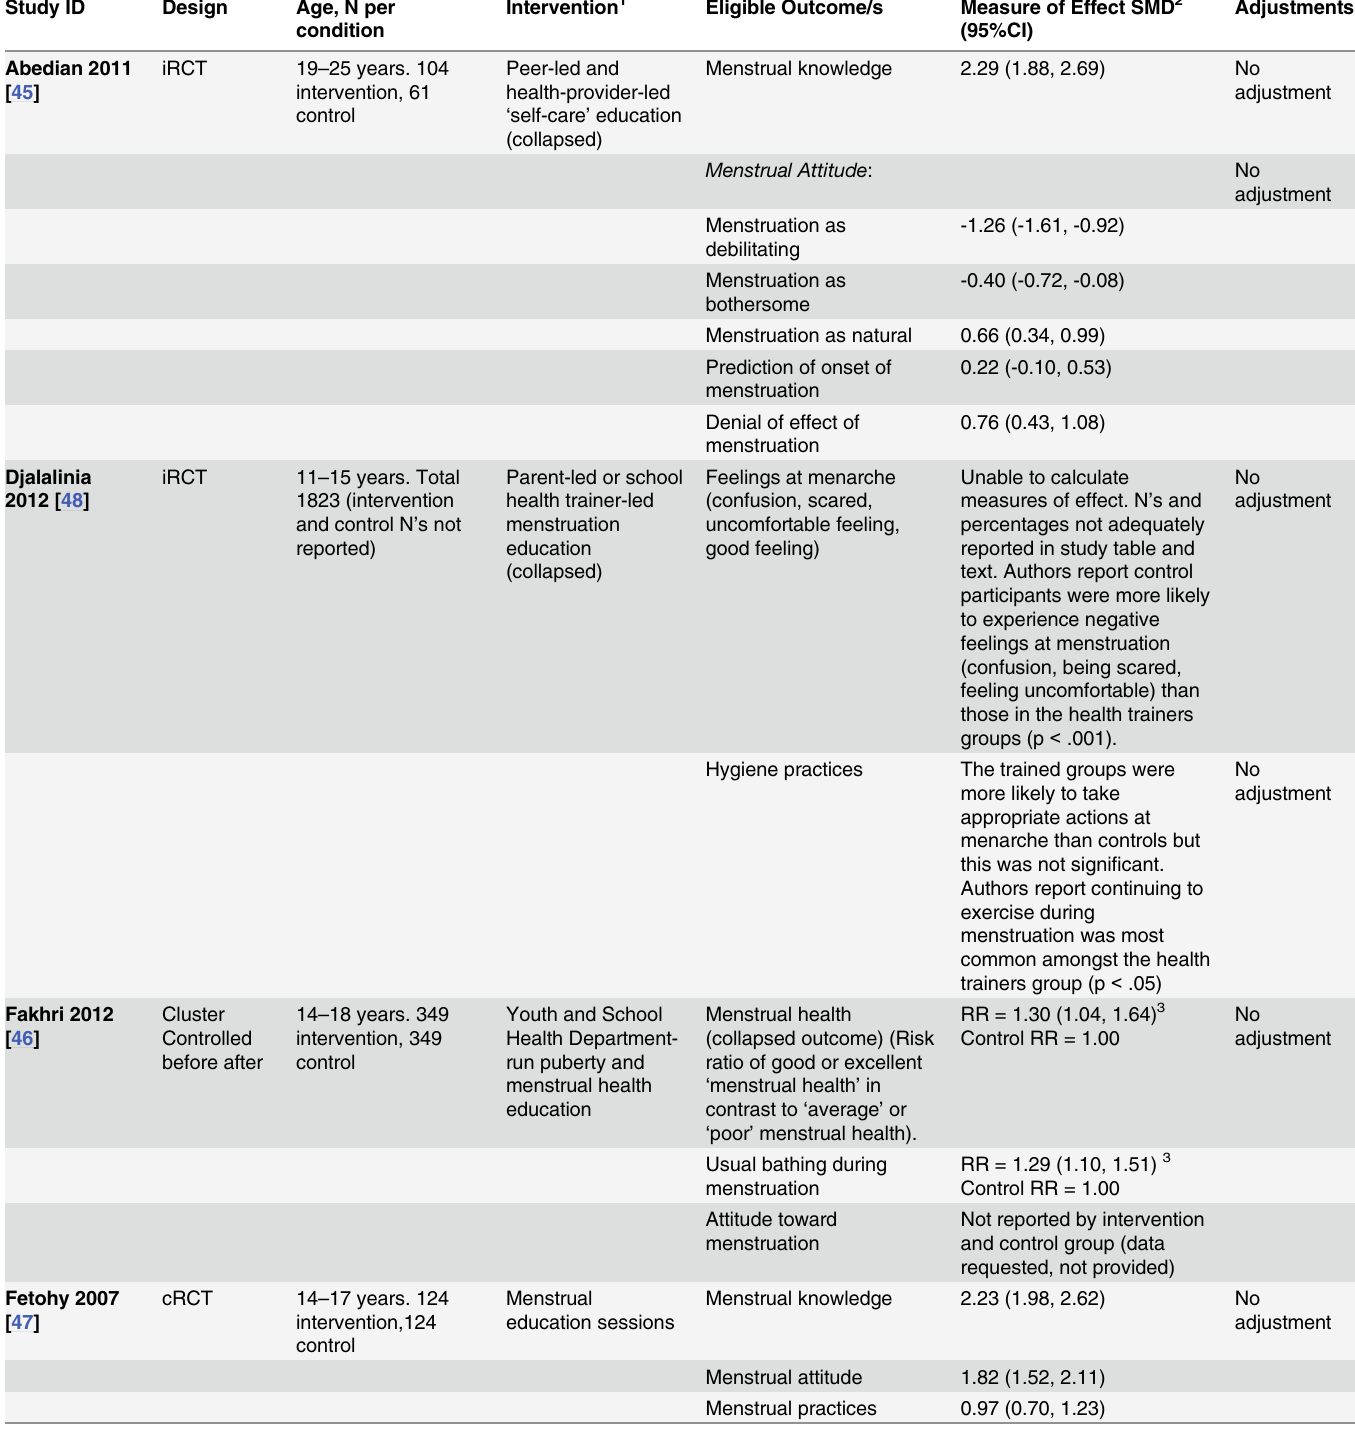
Table 3. Effects of software